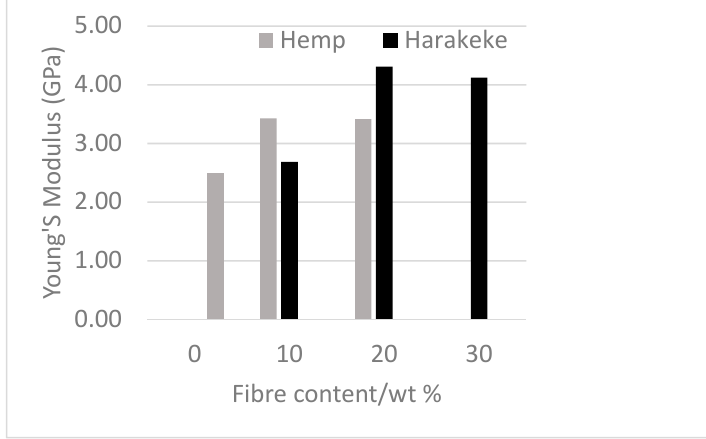
Figure 10. Young’s modulus results of PLA for 10, 20, and 30 wt % hemp and harakeke.